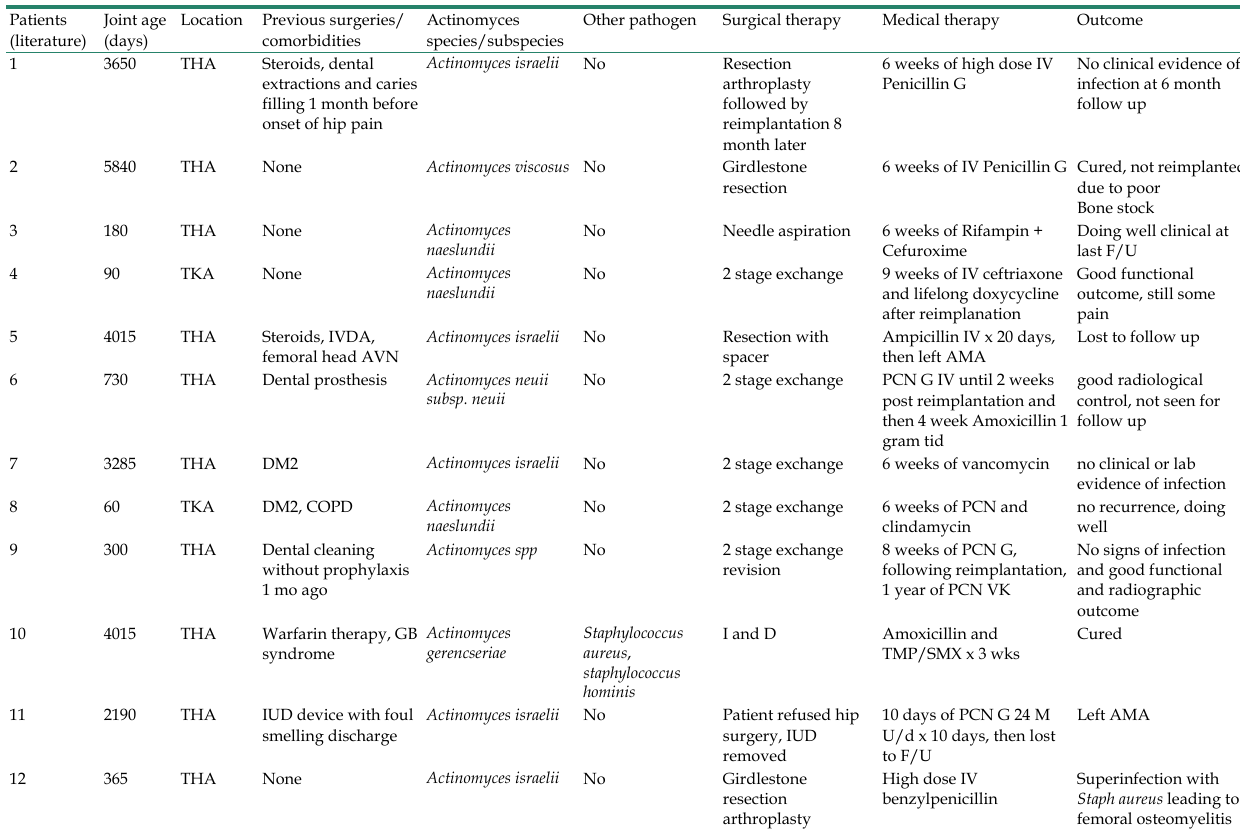
Table 3 . Cases of APJI in literature Patients Joint age (literature)